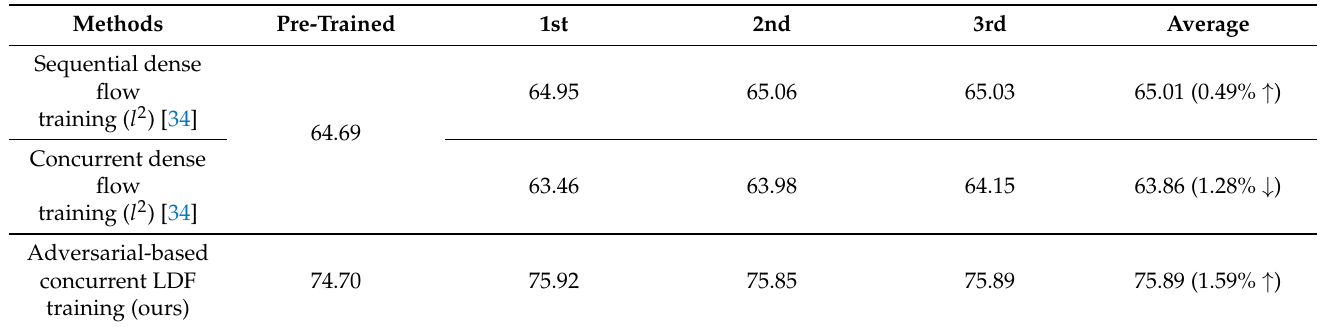
Table 5. Accuracy (%) of CIFAR-100 for the 32-layer pre-trained and 14-layer target ResNets.